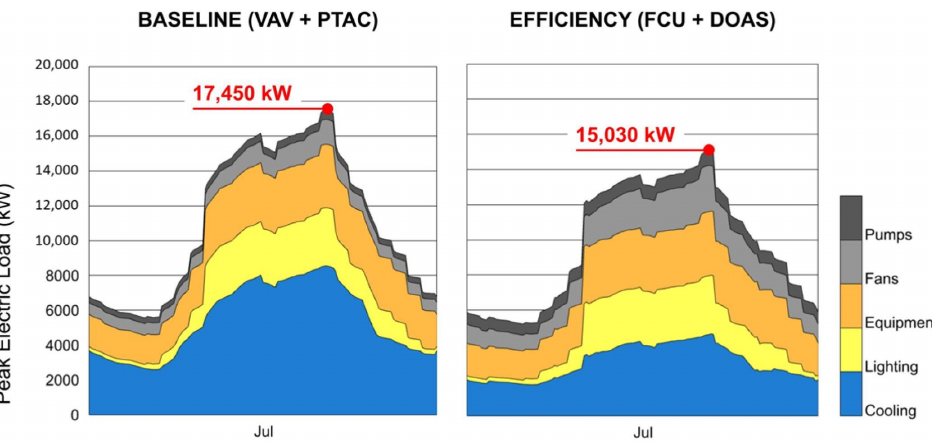
Figure 14. Peak electric profiles on the cooling design day for baseline and high-efficiency HVAC